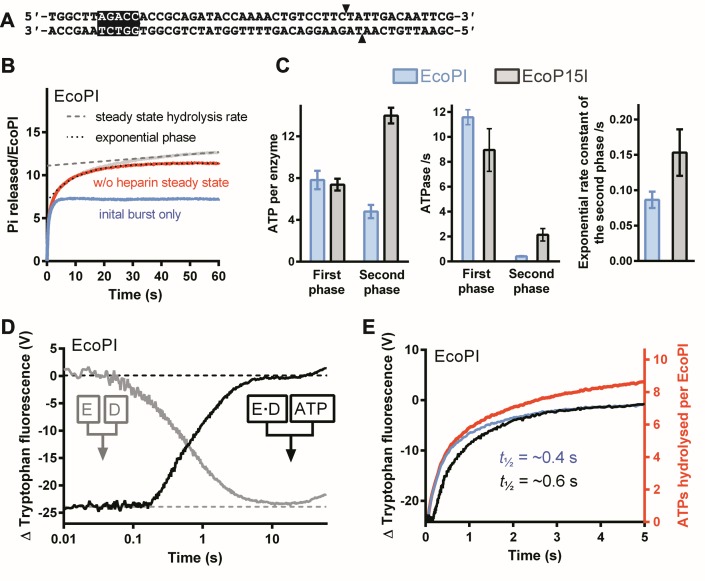
ATPase kinetics of EcoPI on a specific oligoduplex. (A) EcoPI specific oligoduplex substrate (6/38_PI) used here. Arrowheads indicate the sites of cleavage. (B) Preformed EcoPI–oligoduplex complex (25 nM) was rapidly mixed with 4 mM ATP and 200 μM heparin, and the release of phosphate measured (Materials and Methods). Rebinding to the DNA was prevented by the heparin trap. The data was deconvoluted as described in Materials and Methods (4) and shown in Supplementary Figure S1B–D. The grey trace represents the measured unprocessed data from which the steady state corrected trace (red line) is derived by subtracting a linear function (dashed line) fitted to the later stages of the grey trace. The corrected data (red) was fitted to Eq. (2) (dotted line). We can visualize the theoretical first burst phase (blue) by subtracting the exponential function from the corrected profile. (C) Kinetic constants determined for EcoPI on 6/38_PI and EcoP15I on 6/38_P15I. The number of ATPs consumed in the first and second bursts phases were obtained from the A1 and A2 values, respectively, from fits to Eq. (1). The first burst phase ATPase rate was obtained using a linear fit to the initial part of the burst (Supplementary Figure S1D). The ATPase rate of the second phase was calculated using Eq. (2). Averages and standard deviations were calculated from at least two repeats. (D) Measurement of EcoPI conformation change by tryptophan fluorescence measured in a stopped flow fluorimeter (Materials and Methods). The effect of DNA association was measured by mixing EcoPI with 6/38_PI (grey). The effect of DNA dissociation was measured by mixing pre-formed EcoPI–oligoduplex with ATP (black). Final reaction conditions were 1 μM DNA, 250 nM EcoPI, 4 mM ATP and 500 μM heparin. (E) Comparison of the complete (red) and burst (blue) ATPase profiles from panel B with the tryptophan fluorescence changes (black) from panel D.